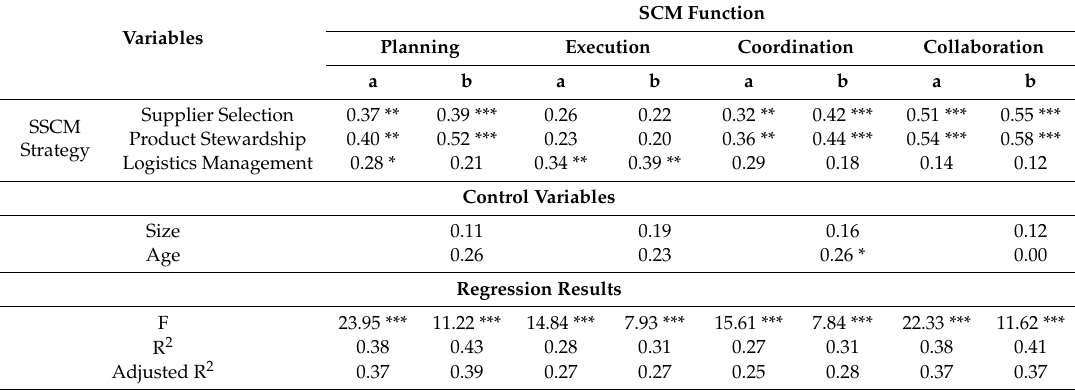
Table 13. Regression results between SSCM strategies and SCM